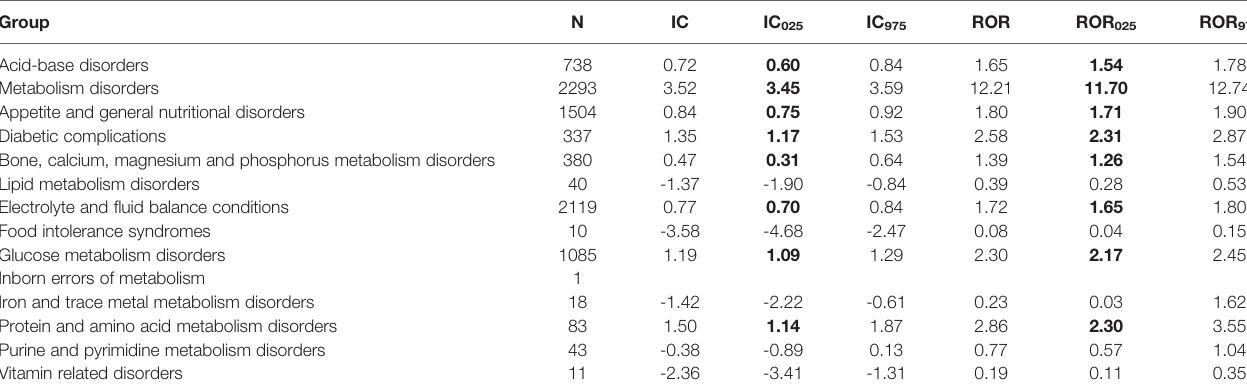
TABLE 3 | Disproportionality for total and class-speci fi c metabolic and nutritional complications after ICIs initiation*. Group